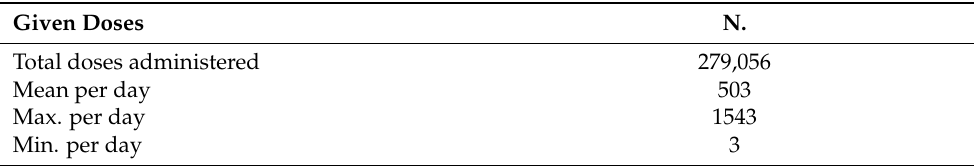
Table 1. Details of the number of doses administered.